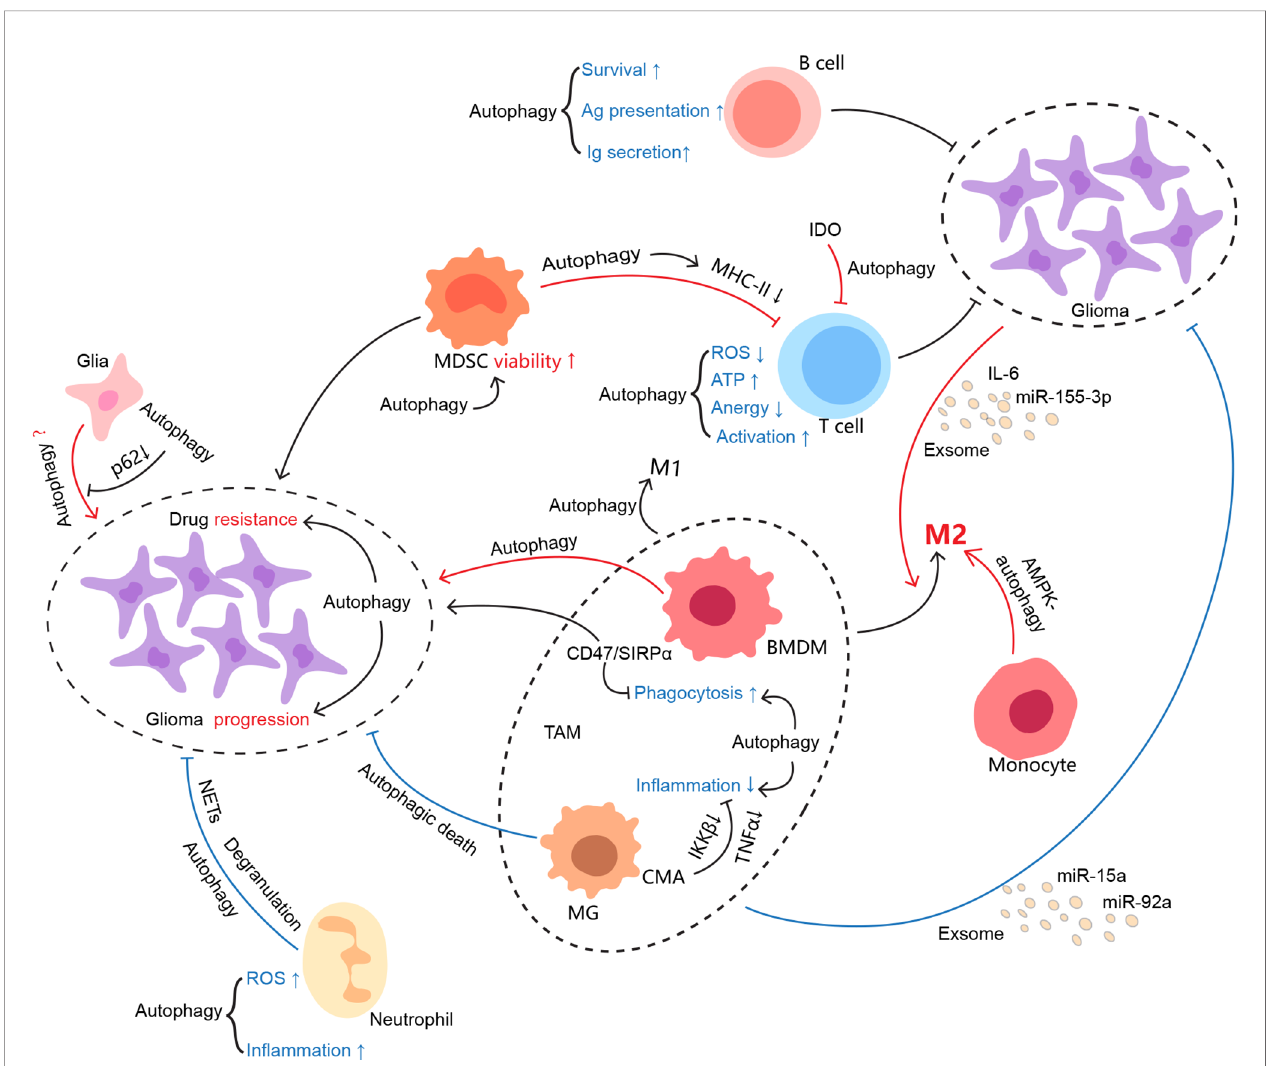
FIGURE 2 | Autophagy involvement in the regulation of theglioma immune microenvironment. As one of the evolutionarily conserved processes, autophagy keepscellular homeostasis not only for immunocytes but also for tumorcells. It may bemanipulated by con fl icting sides in favor of their pro fi ts. However, itseems that autophagy somehow isnot capable of either ensuringthe physiological function ofimmune cells orrestraining glioma growth in the glioma immune microenvironment. The interconnectionsbetween the cellsin theTIME are colored ifautophagyisinvolved, where red indicates protumor effects and blue indicates antitumor